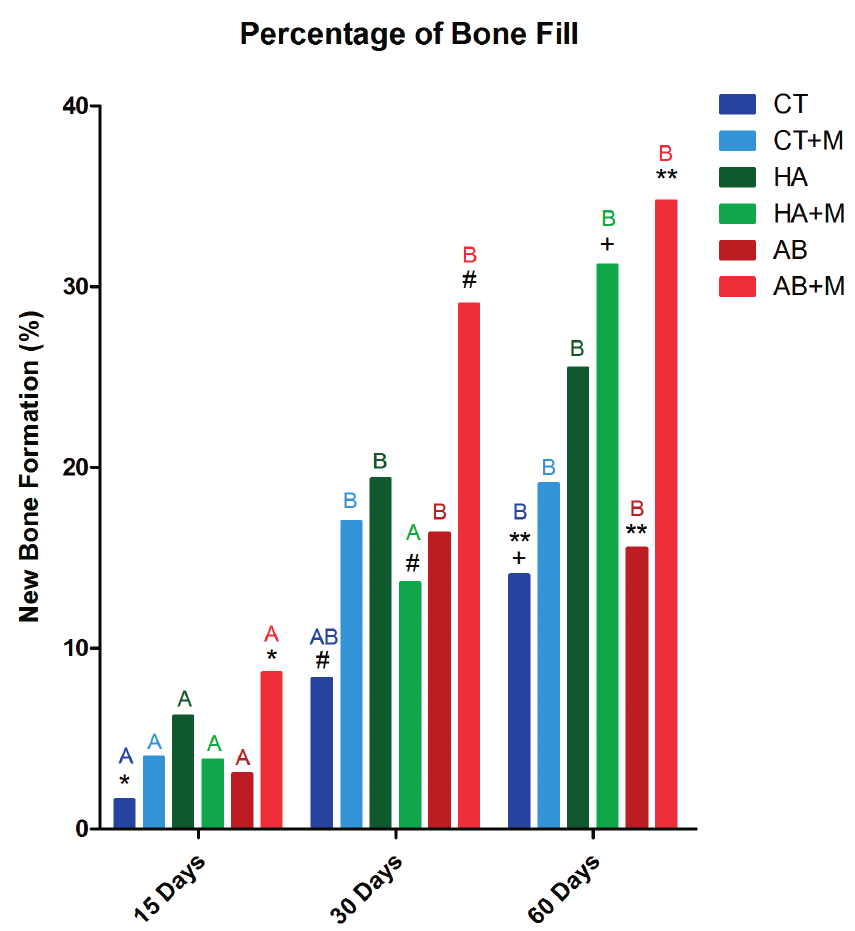
Figure 4- Graphical representation of the percentage of bone formation over time for all groups at 15 postoperative days: AB+M > CT (*); At 30 postoperative days: AB+M > CT (#); At 60 postoperative days: HA+M > CT (+); At 60 postoperative days: AB+M > CT e AB (**). Different capital letters show longitudinal